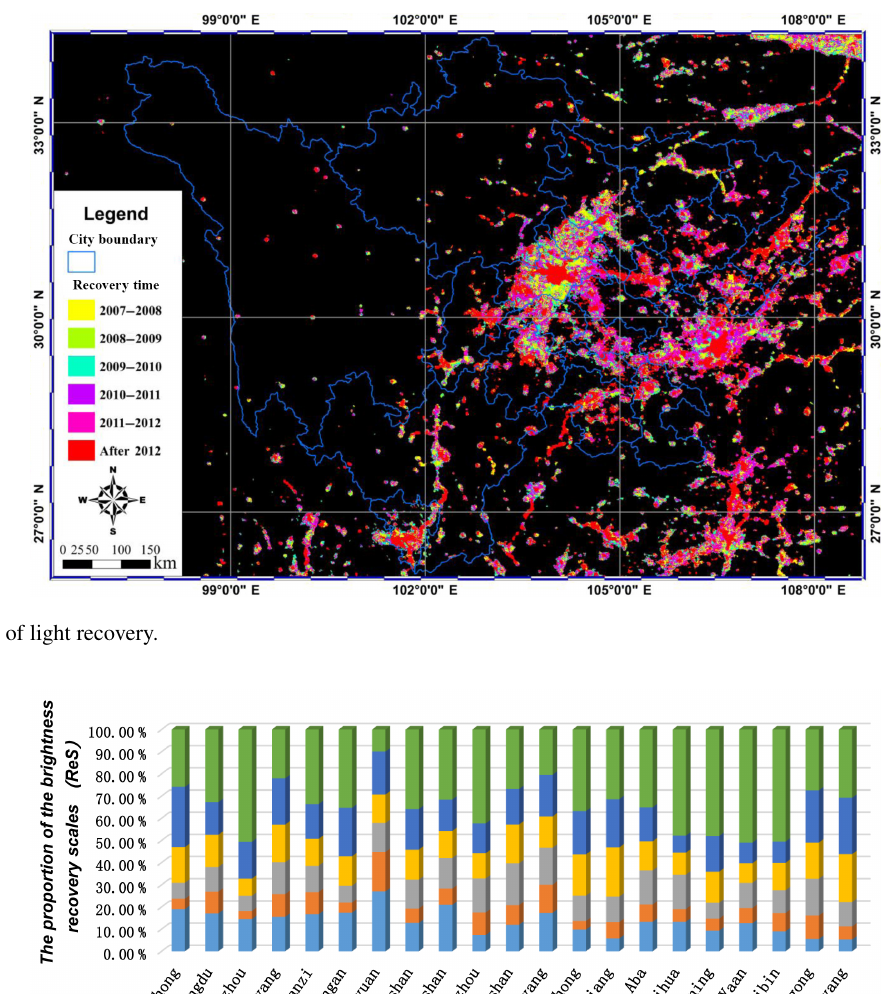
Figure 8. The proportions of the brightness recovery scales.